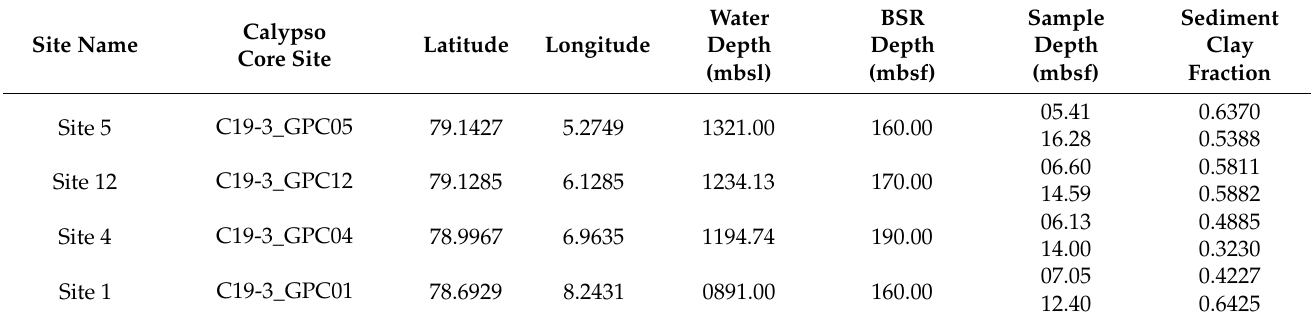
Table 1. Summary of site parameters and sediment clay fraction data. The sites are reported from west to east. Nearly 17 m long calypso cores were retrieved from the corresponding site locations (name, latitude, longitude, water depth). The BSR depth for the respective locations inferred from previous seismic studies [21,42] is mentioned here. Two samples were selected at the mentioned depths for each calypso core. The sediment clay fraction is obtained from index test performed on these